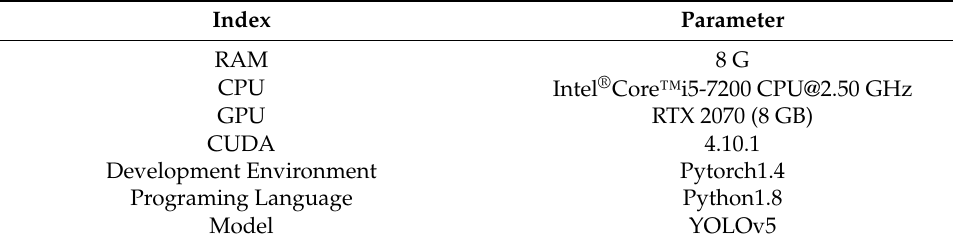
Table 3. Operating environment parameters.